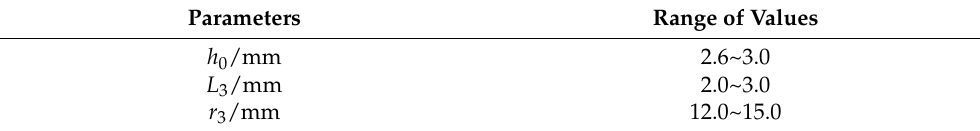
Table 4. Parameter value range.